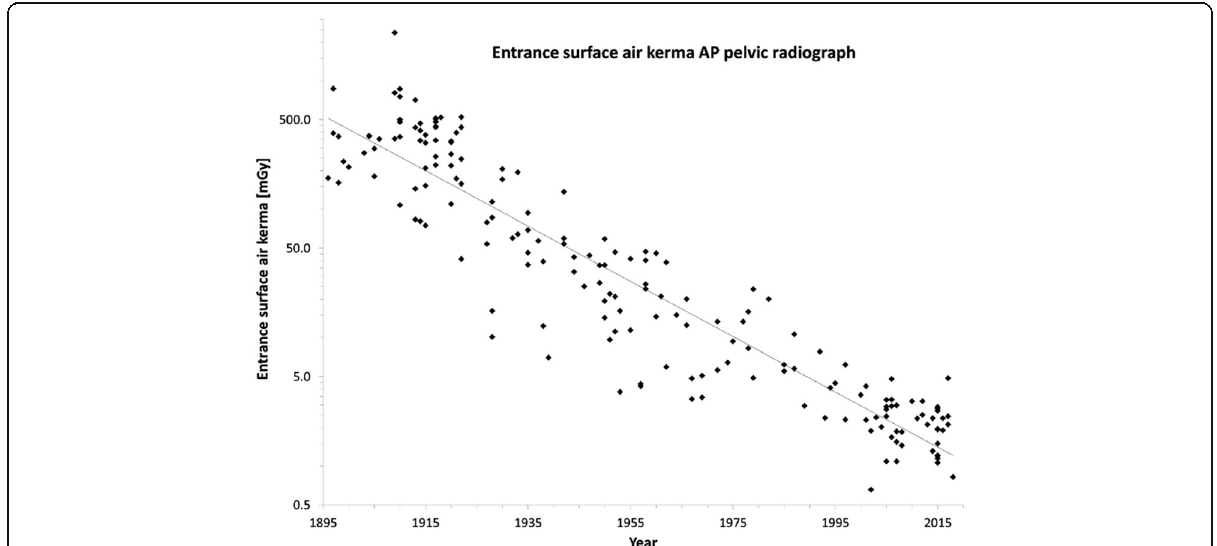
Fig. 3 Entrance surface air kerma including backscatter of an AP pelvic radiograph over the years ( n = 182). Please note the logarithmic y -axis. The solid line is a fit of a simple exponential function to all data ( “ exponential regression ” )